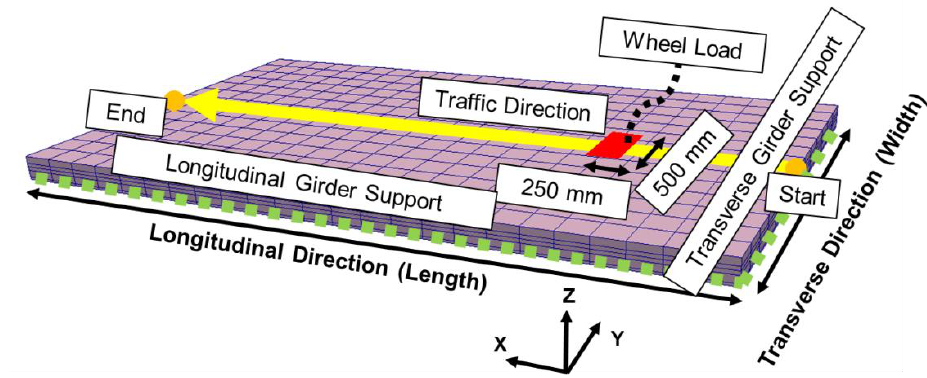
Figure 6. Wheel traveling load on the studied